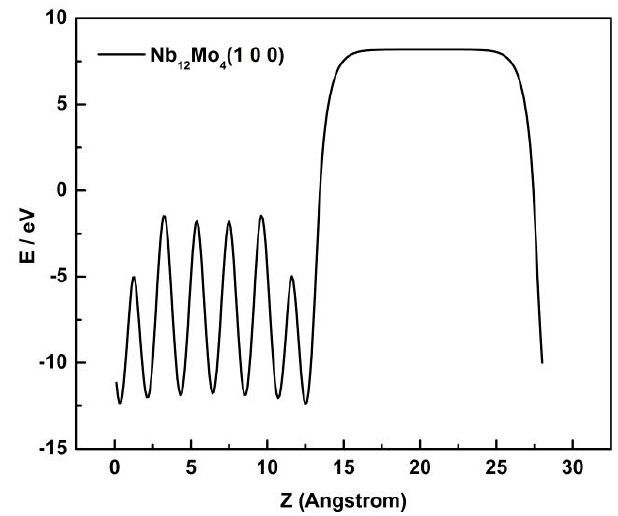
Figure 3. Work function along surface normal direction (Z-axis) for Nb 12 Mo 4 (100) surface model with seven atomic layers.